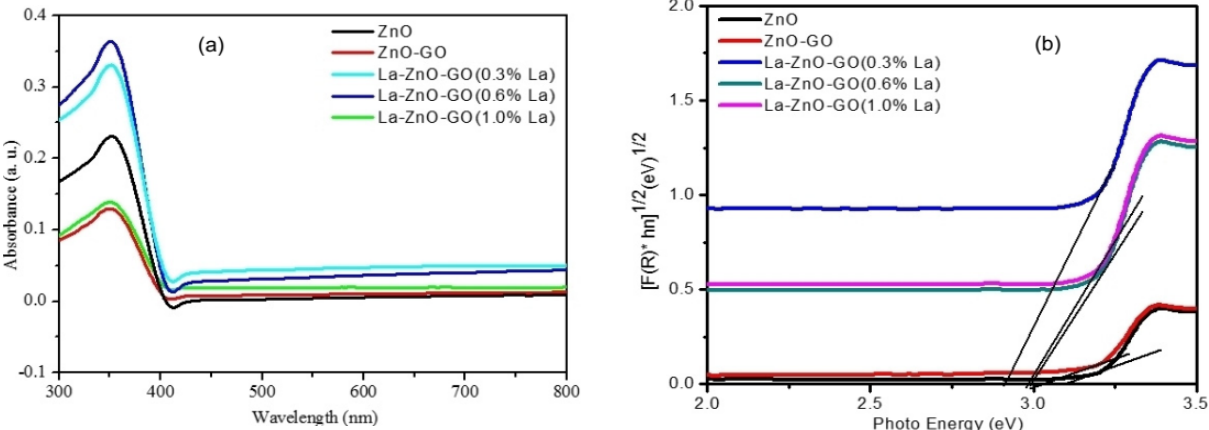
Figure 13. UV-Vis spectra ( a ) and Tauc plots ( b ) for La-doped-ZnO nanomaterials decorated on graphene oxide [75].